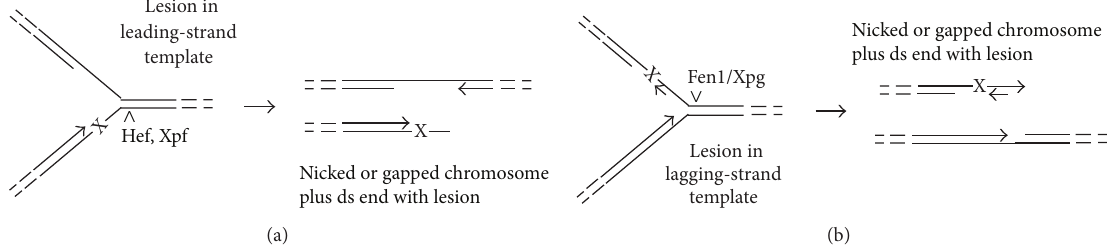
Figure 2: Fork breakage “collapse” in response to replication-blocking lesions. Adducts or other large, helix-distorting lesions (symbolized by X) block a polymerase molecule, inducing a certain degree of uncoupling and ssDNA exposure at the base of the fork. Cleavage by an appropriate single-strand-specific or structure-specific endonuclease can, for each case, generate dsDNA end that retains the lesion. The top strand in each DNA duplex is oriented with the 5 󸀠 end on left; free 3 󸀠 ends are represented by arrowheads, whereas broken lines indicate the rest of the chromosome. Carets ( ∧ ) locate the single cut that would be made by the indicated nuclease. For the cleavage preferences of archaeal Hef, Xpf, and Fen1/Xpg, see [36, 65,